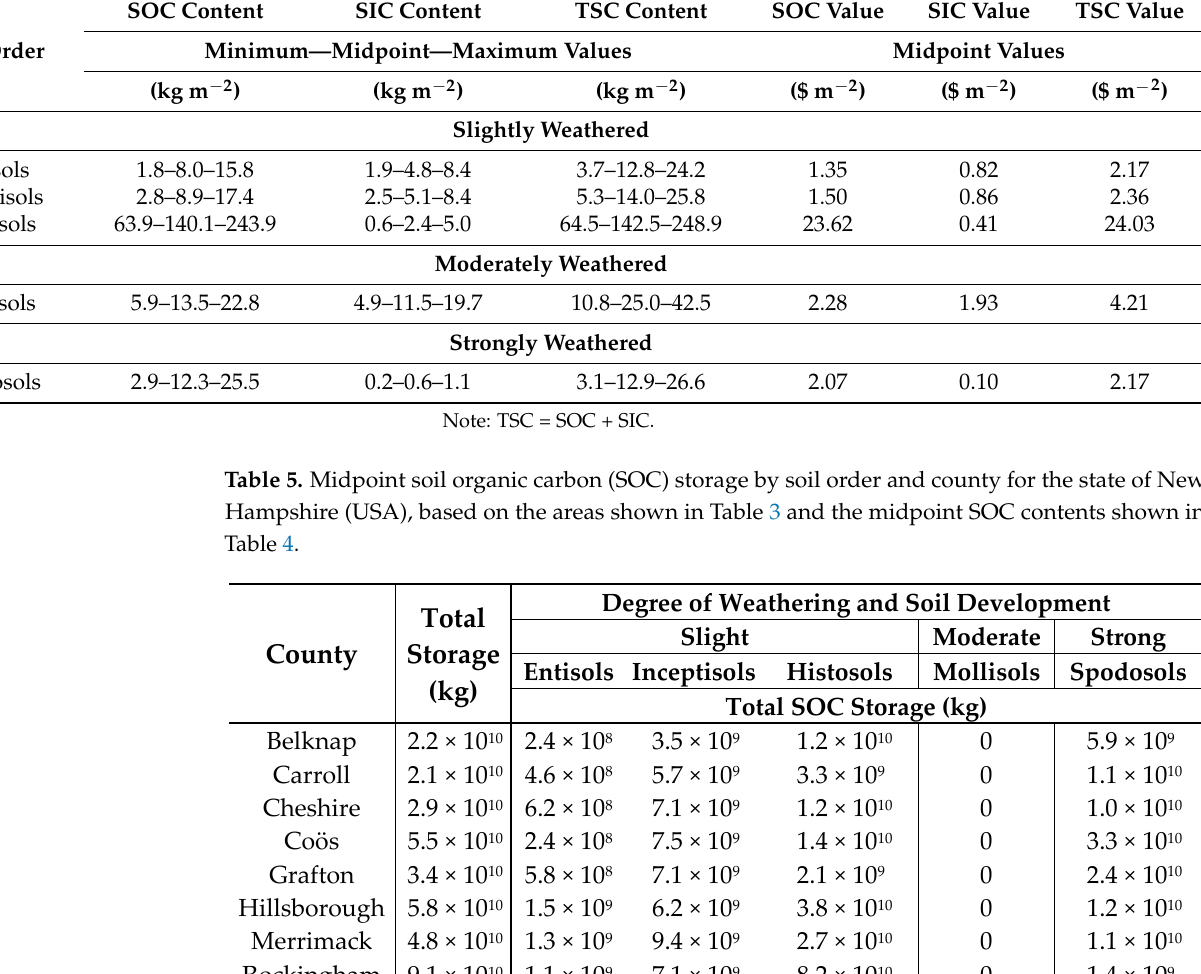
Table 4. Area-normalized content (kg m − 2 ) and monetary values ($ m − 2 ) of soil organic carbon (SOC), soil inorganic carbon (SIC), and total soil carbon (TSC) by soil order based on data reported by Guo et al. [20] for the upper 2 m of soil and an avoided social cost of carbon (SC-CO 2 ) of $46 per metric ton of CO 2 (2007 U.S. dollars with an average discount rate of 3% [19]).